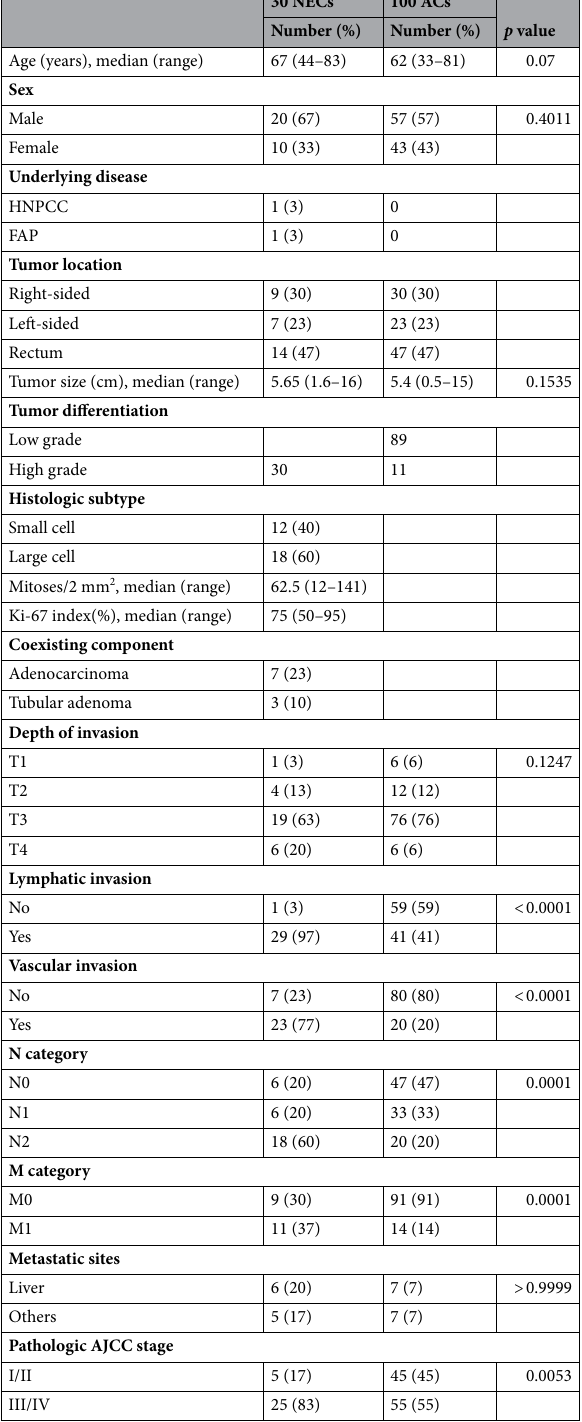
Table 1. Comparison of clinicopathologic features between NECs and ACs after matching tumour site. HNPCC hereditary nonpolyposis colorectal cancer, FAP familial adenomatous